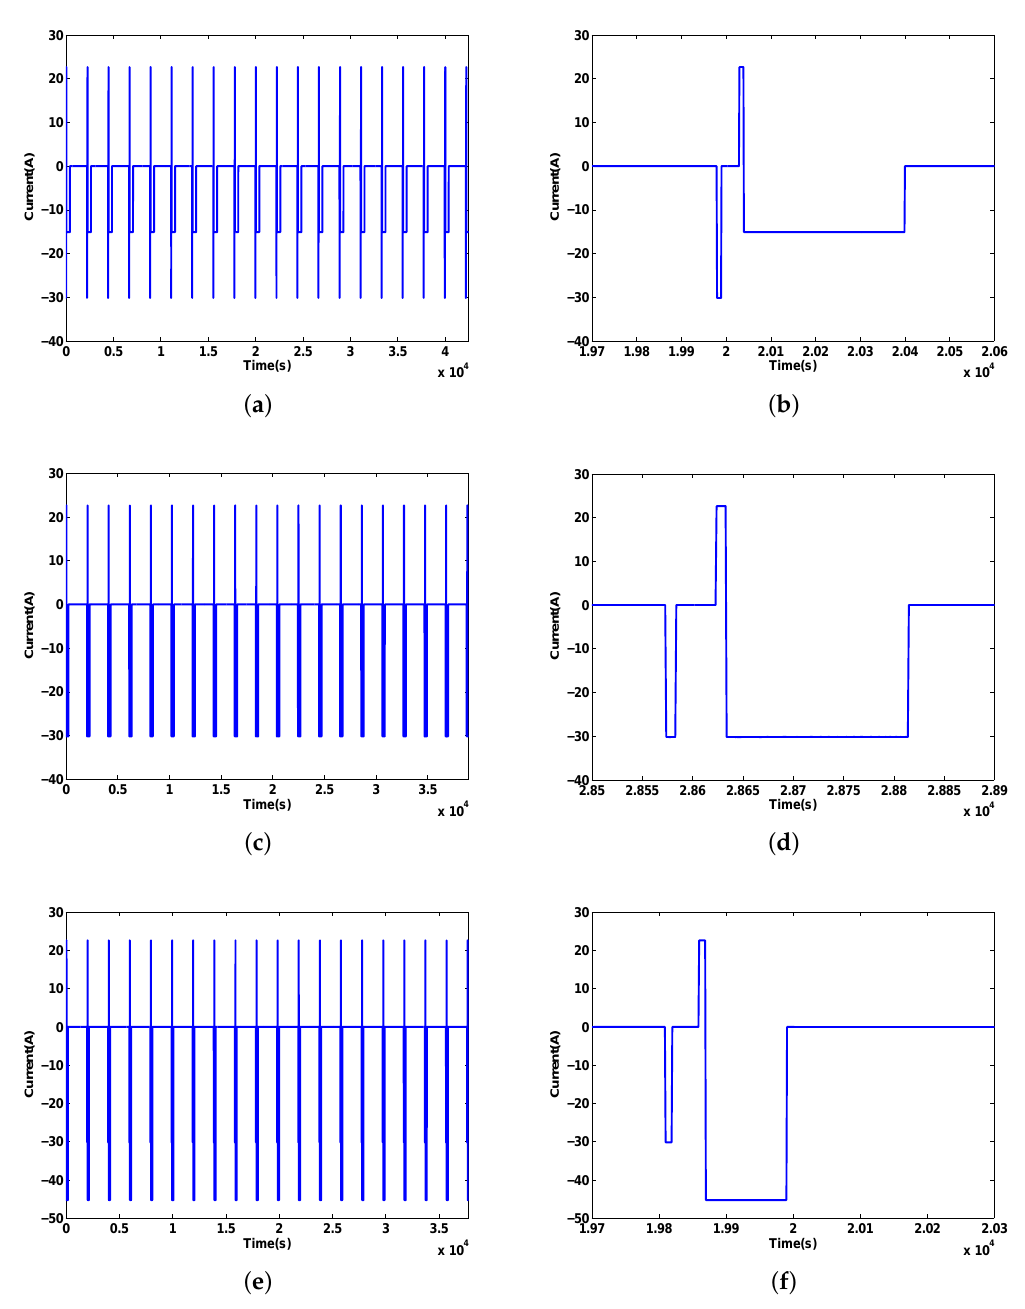
Figure 4. Testing cycle currents: ( a ) pulse and 0.5C constant current; ( c ) pulse and 1C constant current and ( e ) pulse and 1.5C constant current; ( b ), ( d ) and ( f ) are the zoom of ( a ), ( c ) and ( e ),